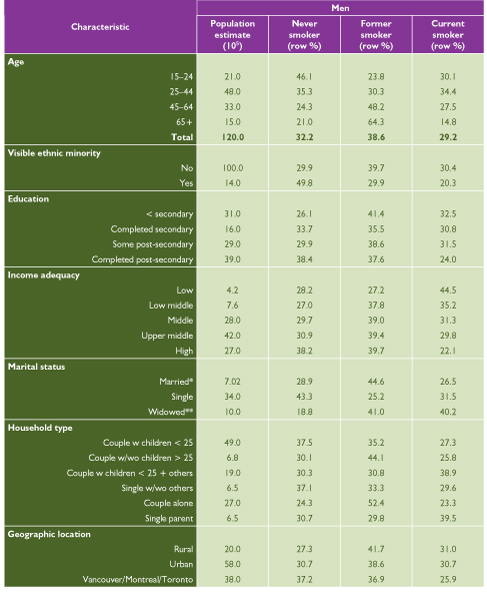
Socio-demographic Characteristics of Never Smokers, Former Smokers and Current Smokers: Men (NPHS 1998–1999)